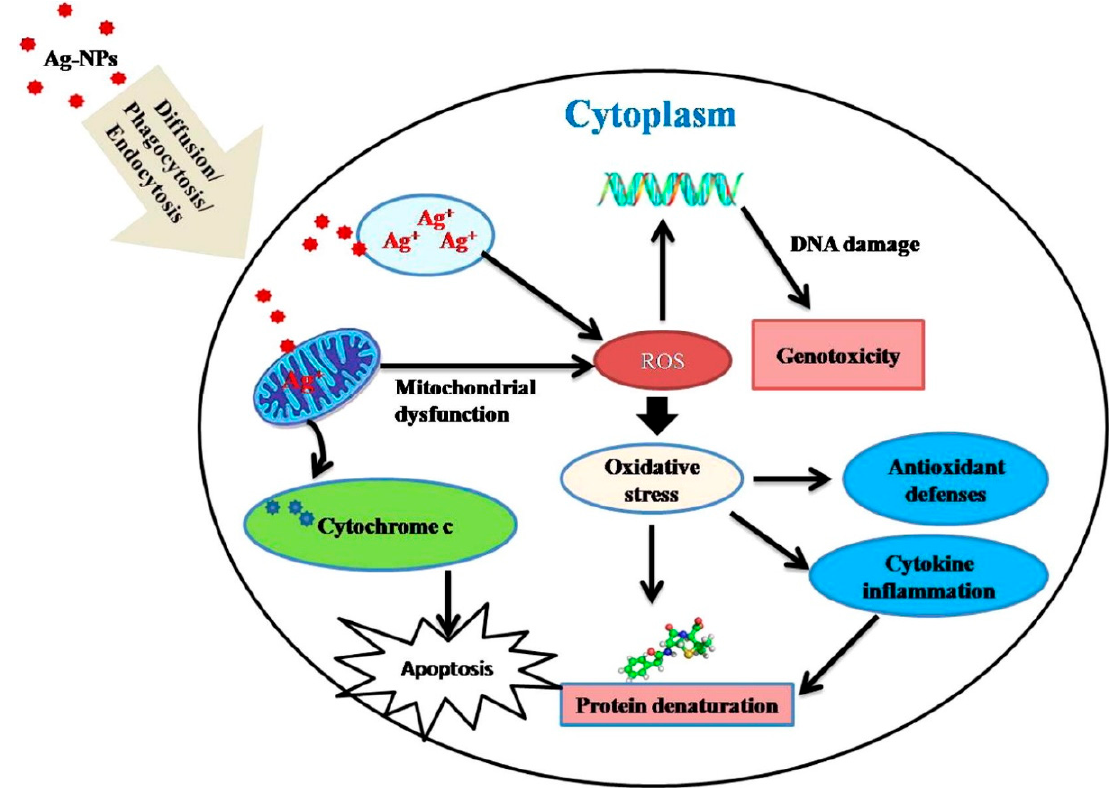
Figure 2. The possible uptake process and mechanism of cytotoxicity induced by Ag-NPs in different cell lines are based on several studies’ metadata. Reprinted with permission according to license CC BY-NC-ND 4.0 [18].